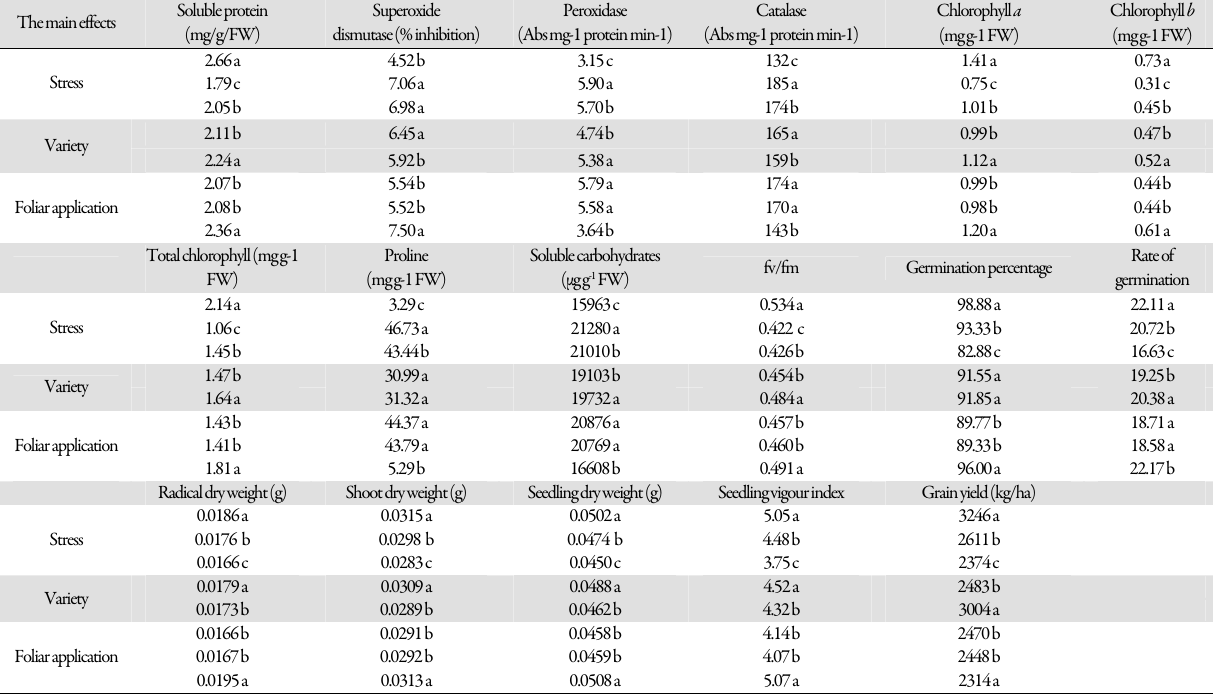
Table 2. Mean comparison on yield, physiological traits and seed vigor of two soybean cultivars The main